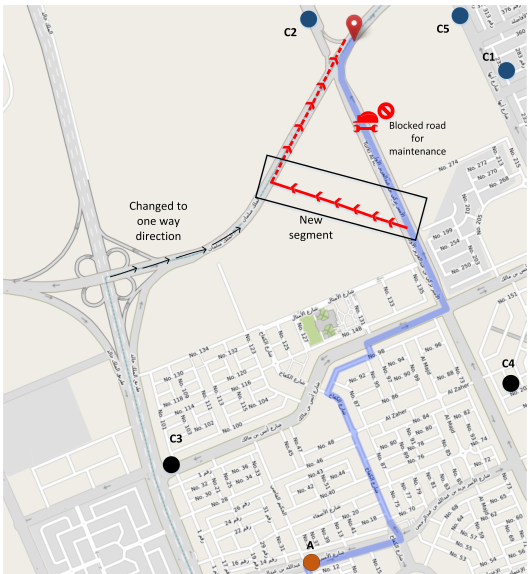
Figure 13. An example of the automatic road monitoring